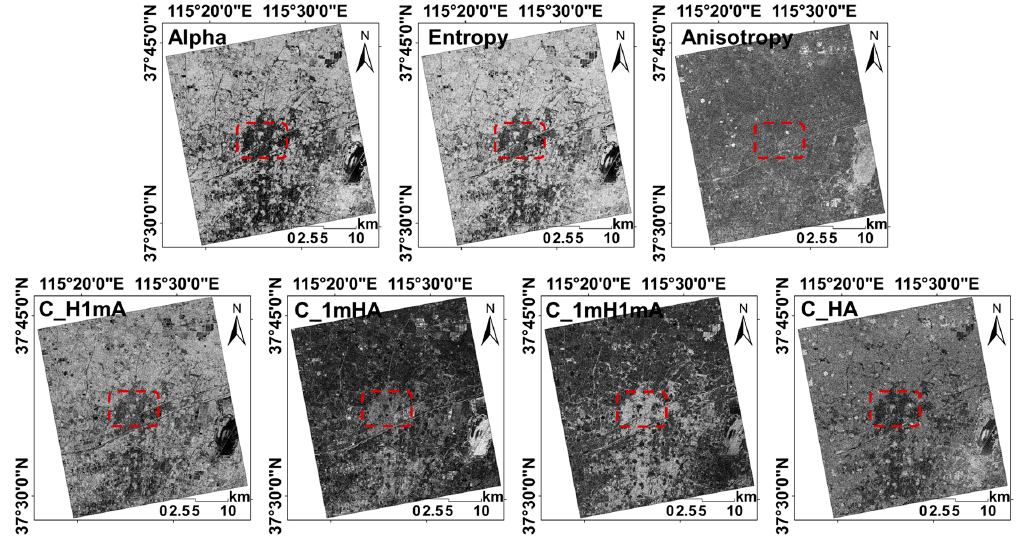
Figure 7. The images of H/A/Alpha polarization decomposition (the red dashed rectangle represents the main PMF region).